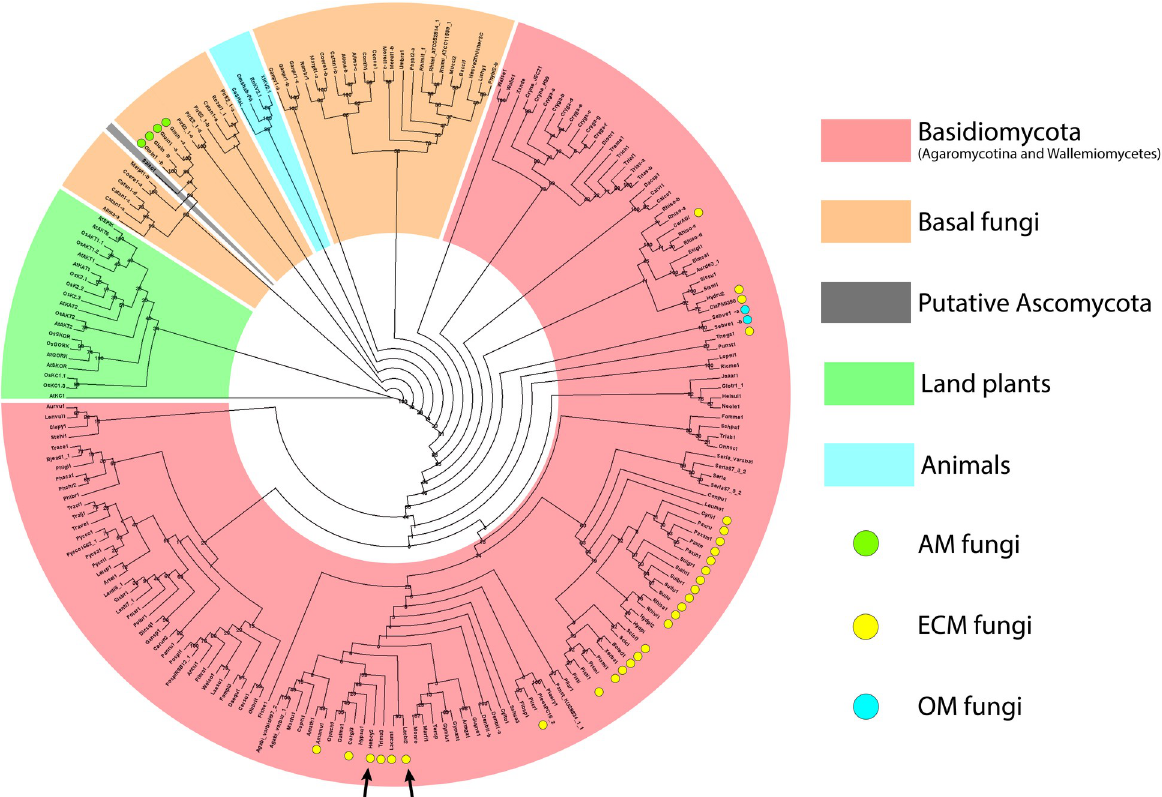
Fig 2. Phylogenetic tree of K V channels in fungi, and representative animal and plant species. The Shaker -like K + channel tree of publicly available sequenced fungi from the Basidiomycota phylum and from basal fungi (Cryptomycota, Chytridiomycota, Blastocladiomycota, Zoopagomycota and Mucoromycota) was calculated by the maximum likelihood method (1000 bootstraps). Shaker -like proteins were found only in one putative Ascomycota species ( Saitoella complicata ) and not in the Pucciniomycotina and Ustilaginomycotina subphyla of Basidiomycota. Ectomycorrhizal (ECM), arbuscular mycorrhizal (AM), and orchid mycorrhizal (OM) fungi are indicated by yellow, green, and blue dots, respectively. K V channels from representative land plant and animal species were included in the tree. All species displayed in this tree are listed in the S2 Table. Shaker -like proteins from H . cylindrosporum ( Hc SKC) and L . bicolor ( Lb SKC) used in this study are indicated by black arrows.